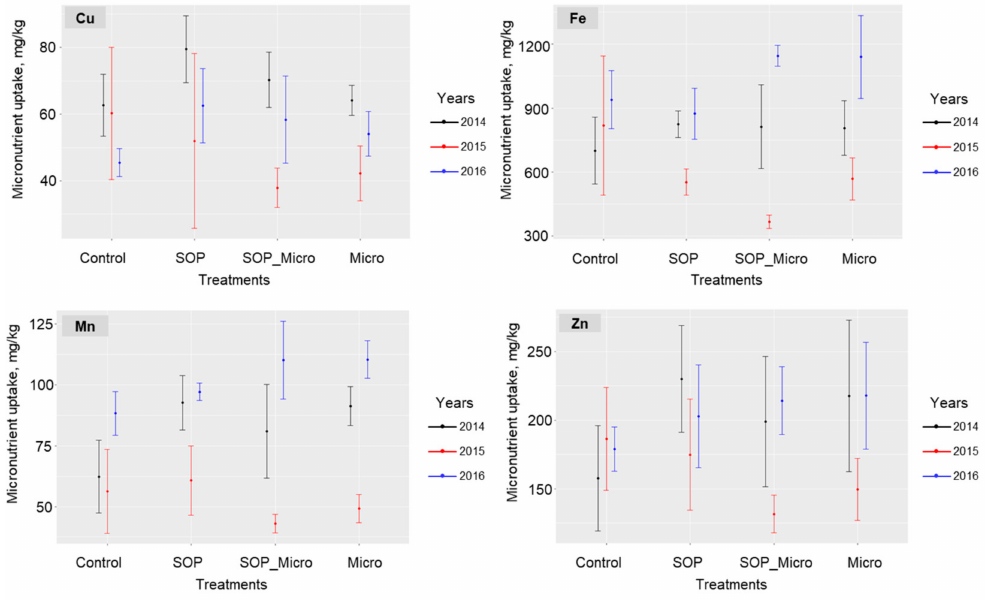
Figure 6. E ff ect of foliar fertilization with potassium and micronutrients on micronutrient uptake in the variety Hermes at the stage in full